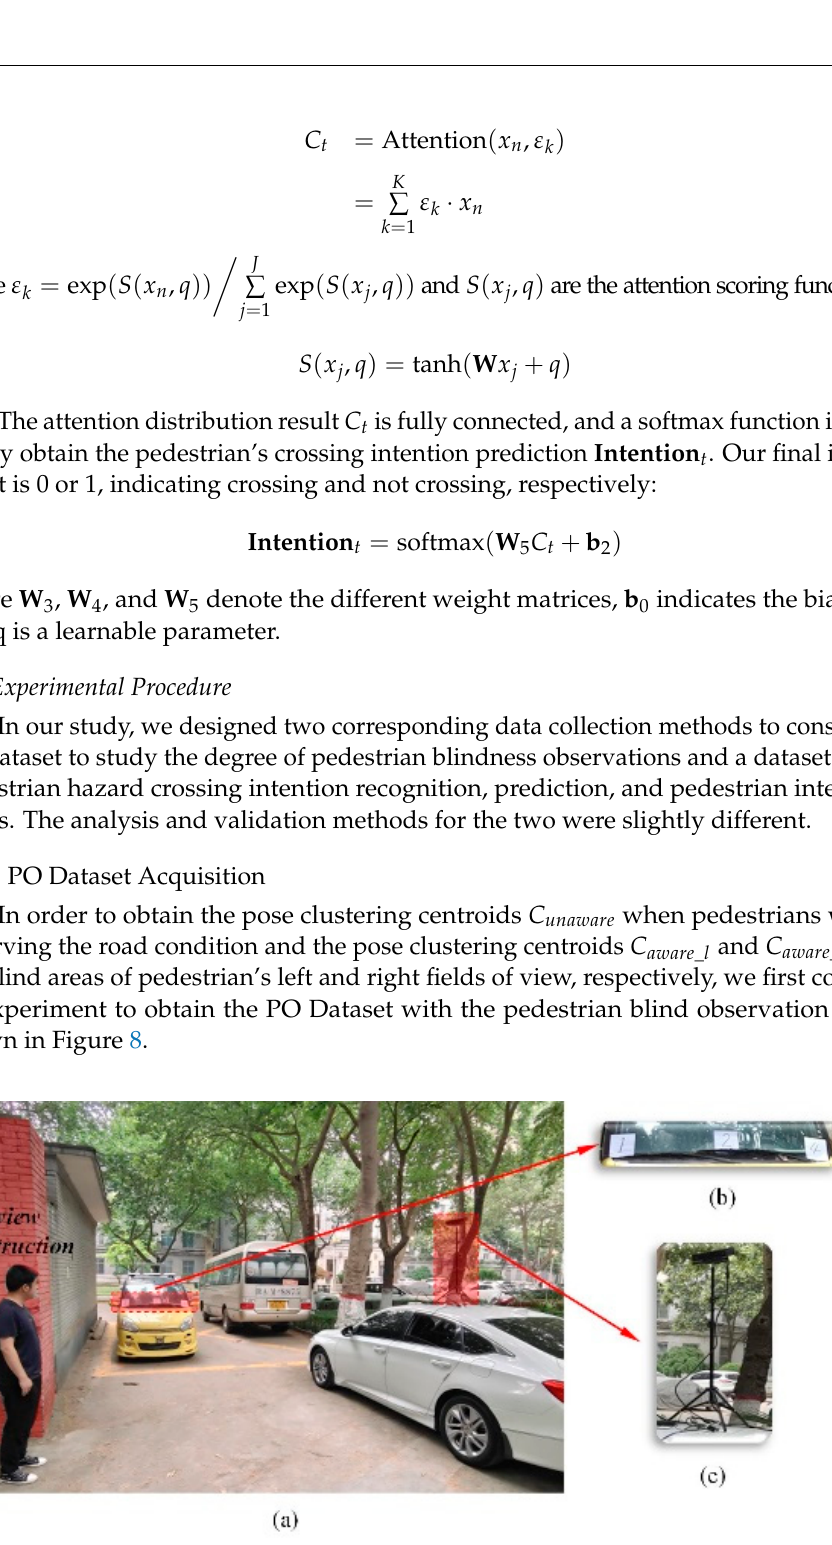
Figure 8. Schematic diagram of the experimental data collection for the pedestrian blind spot observation status. ( a ) Schematic diagram of the experimental site. ( b ) Observed vehicle and information panels. ( c ) Camera used in the experiment.